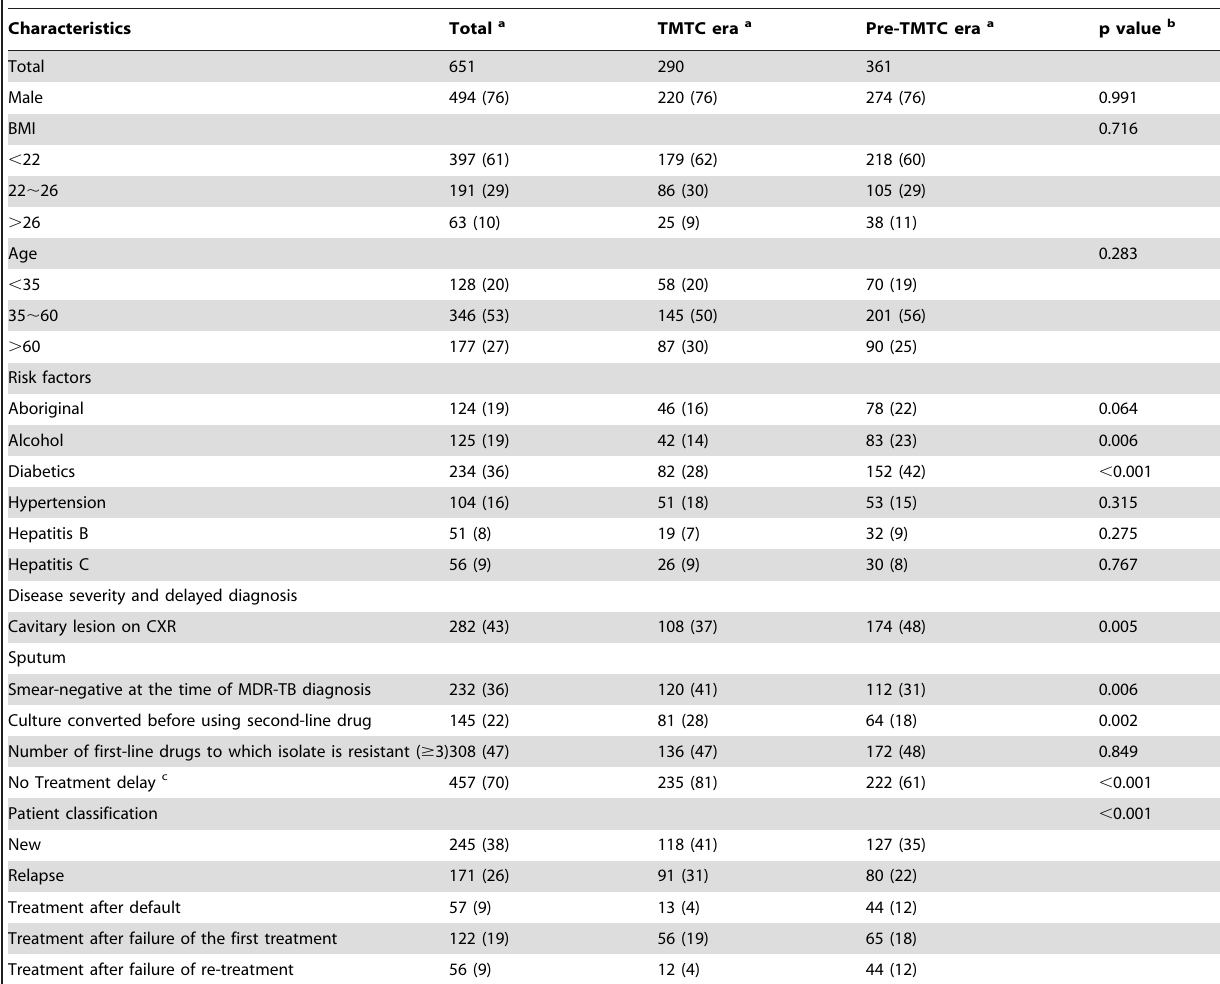
Table 1. Characteristics of the 651